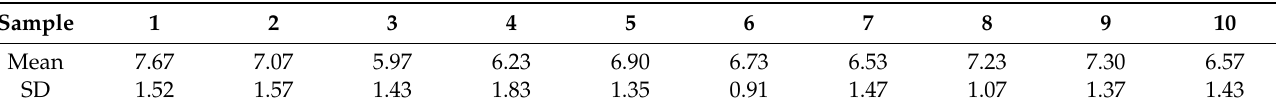
Table 16. Average score of appearance evaluation of 10 samples (10-point